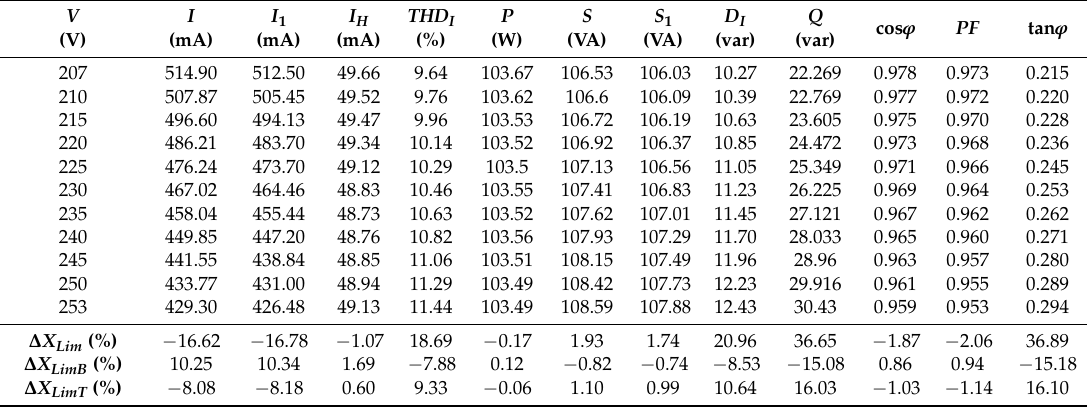
Table 1. Summary of the measured values of the electrical parameters of the lighting luminaires marked as